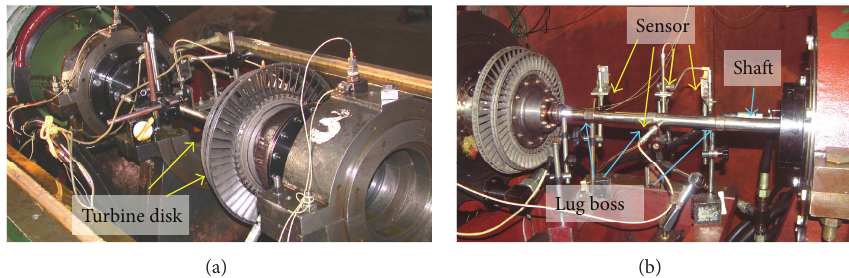
Figure 9: The experimental test turbine (a) rotor mounted on vibration generator and (b) close view of lug boss and sensor.